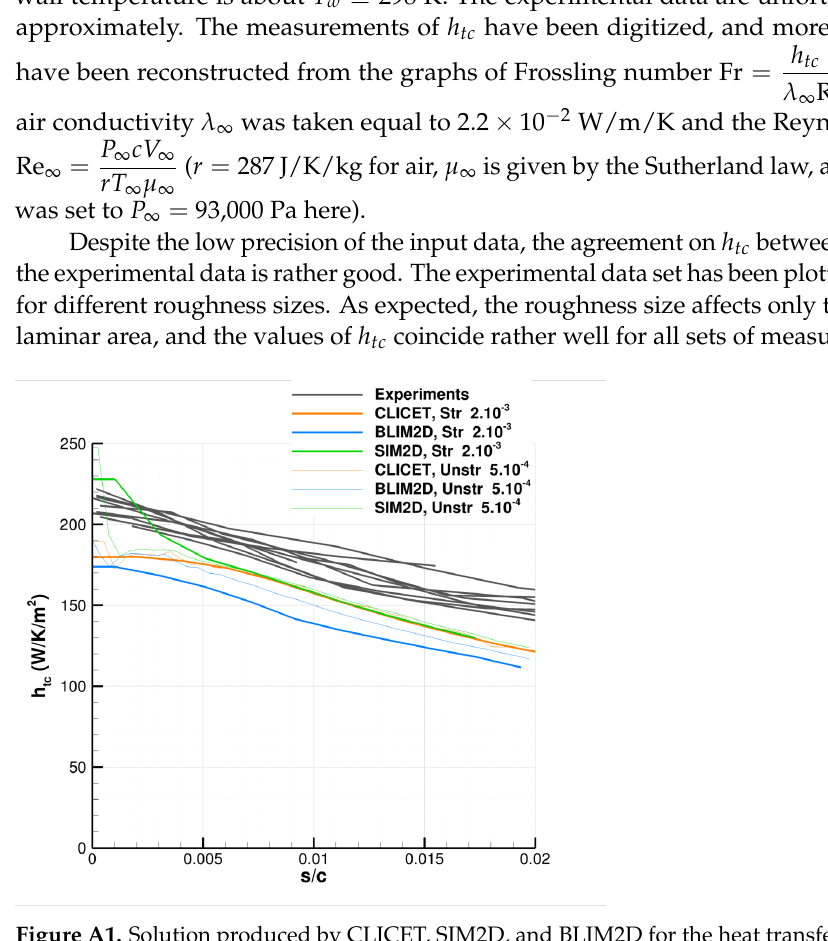
Figure A1. Solution produced by CLICET, SIM2D, and BLIM2D for the heat transfer coefficient with respect to the curvilinear abscissa s in the laminar area of Han and Palacios’s experiment for several meshes. Comparison against the experimental